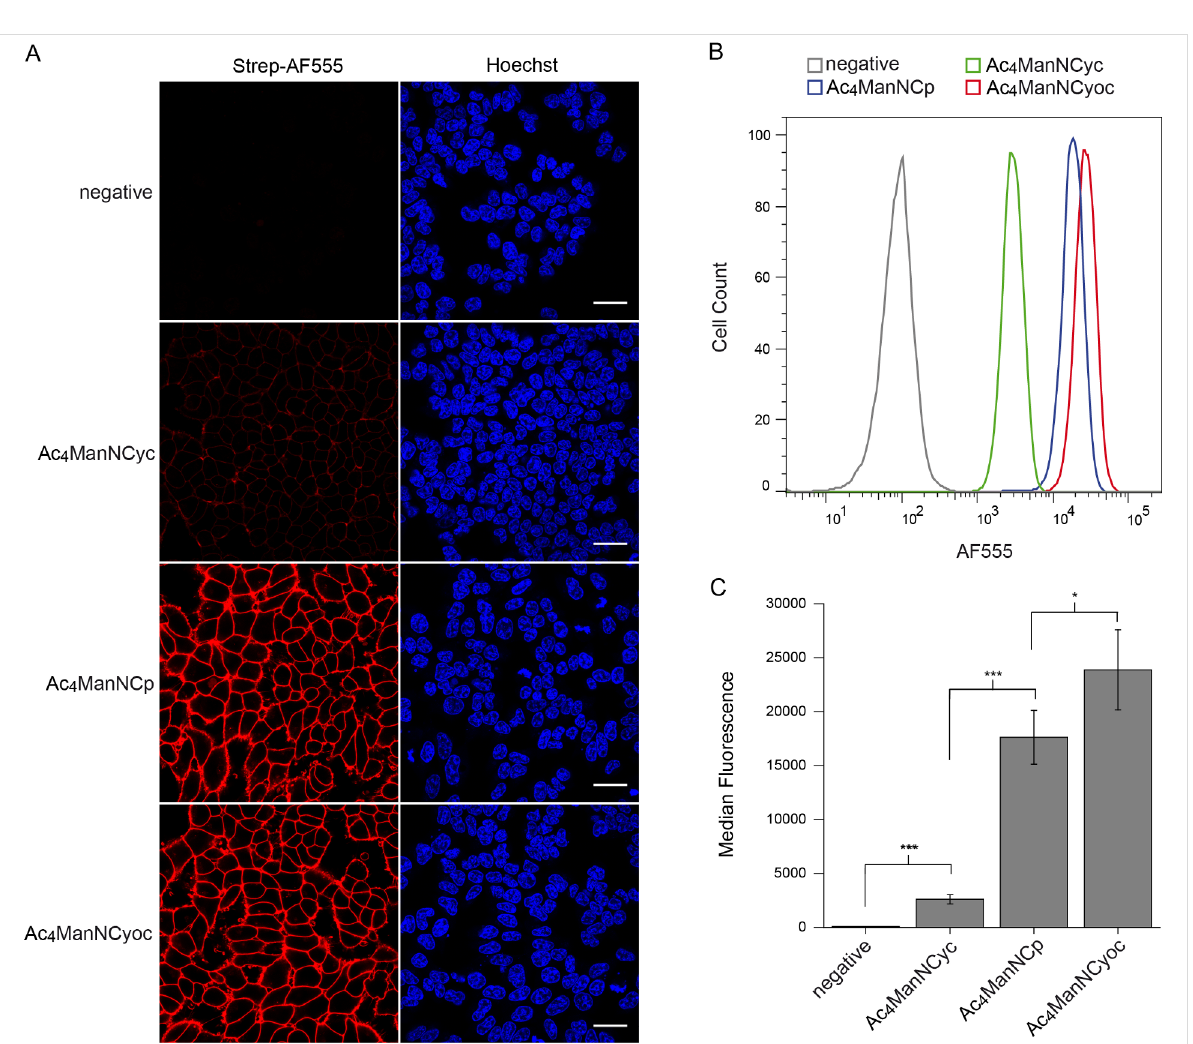
Figure 3: HEK 293T cells were grown with 100 μ M Ac 4 ManNCyc, Ac 4 ManNCp, Ac 4 ManNCyoc or DMSO only (negative control) for 48 h. Cells were incubated with Tz-biotin (100 μ M) for 1 h (A) or 30 min (B,C) at 37 °C followed by incubation with strep-AF555. A) Results from confocal fluorescence microscopy. Nuclei were stained with Hoechst 33342. Scale bar: 30 μ m. B) Histogram from flow cytometry experiments. C) Median fluorescence from five independent flow cytometry